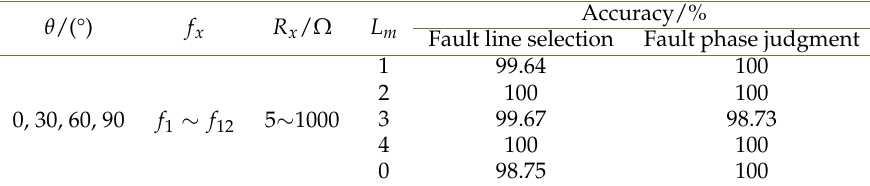
Table 10. Testing results of L 5 added